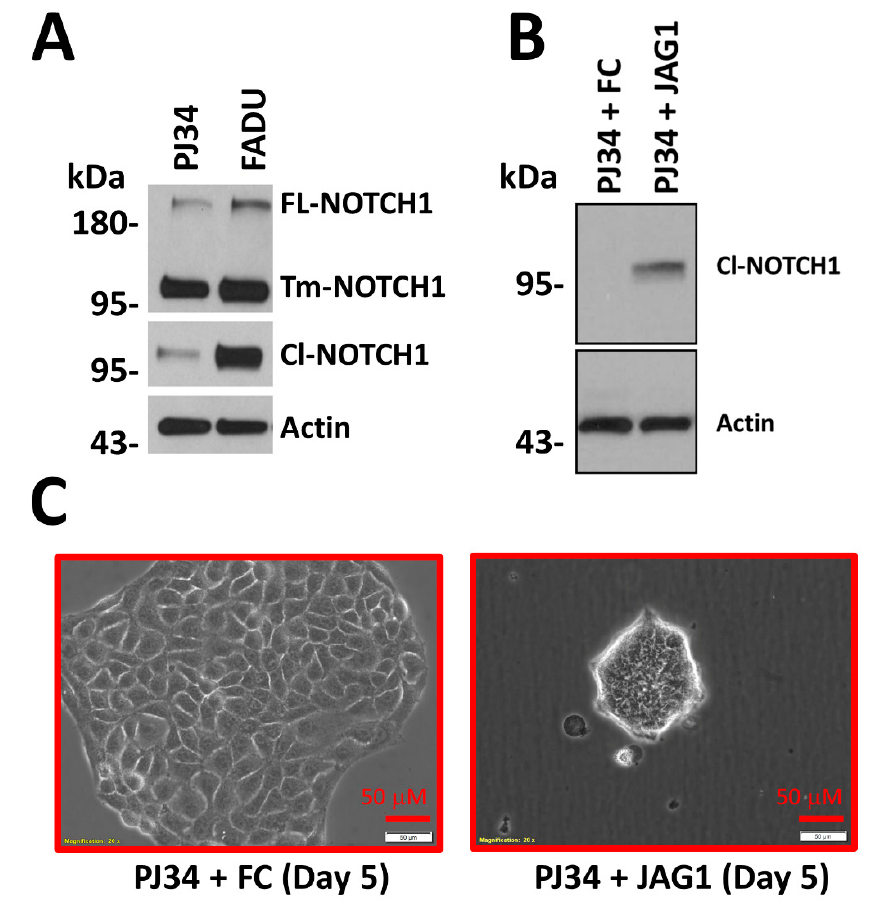
Figure 7. NOTCH1 pathway activation is associated with morphological change in a HNSCC cell line harboring wt NOTCH1. ( A ) Strong total NOTCH1 protein expression is evident in two HNSCC cell lines (PJ34 and FaDu) with wt NOTCH1, but baseline pathway activation detected with an antibody to ICN1 is much stronger in FaDu cells. ( B ) Cultivation of PJ34 on immobilized NOTCH1 ligand (JAG1) for 16 h dramatically increases the amount of detectable ICN1 compared to growth on immobilized control (FC) protein. ( C ) Morphology changes in PJ34 after growth on JAG1 ligand detectable as early as within 3 days become prominent by day 5, and are characterized by drastic reduction in individual cell size and a shift to form loosely attached spheroids. FL, Full-length; Tm, Transmembrane domain; Cl, Cleaved.